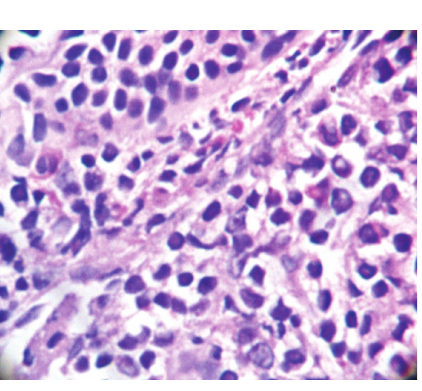
Figure 3: High-power view showing blast (tumour) cells which are round to oval with high nuclear cytoplasmic ratio and increased